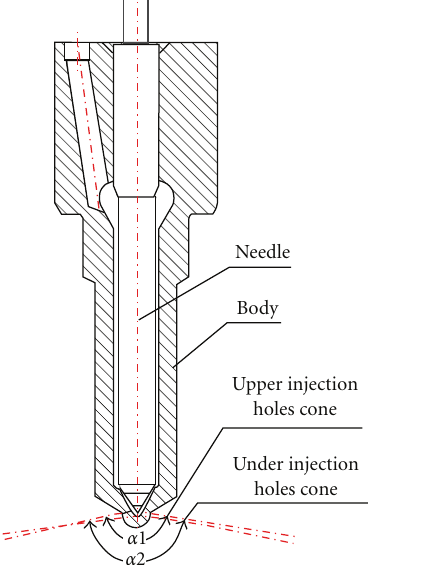
Figure 4: Schematic of UMH Nozzle [20].